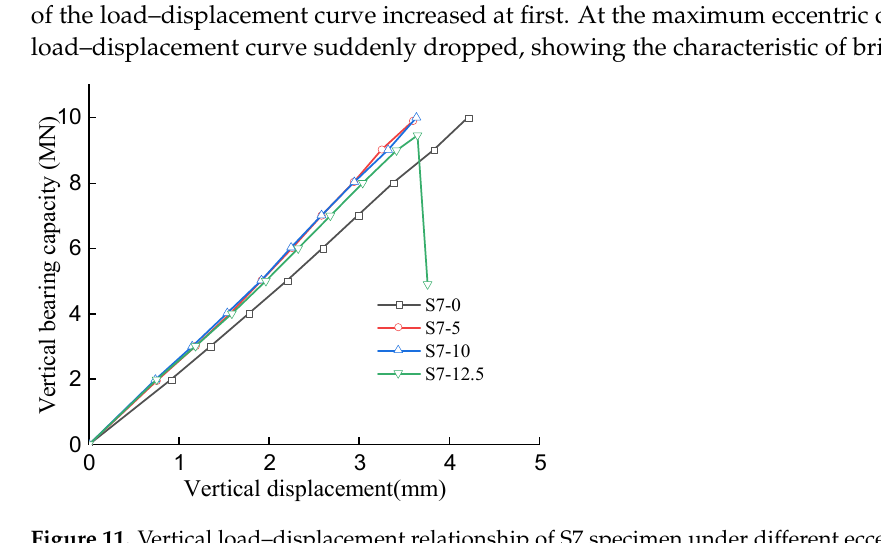
Figure 11. Vertical load–displacement relationship of S7 specimen under different eccentricity.